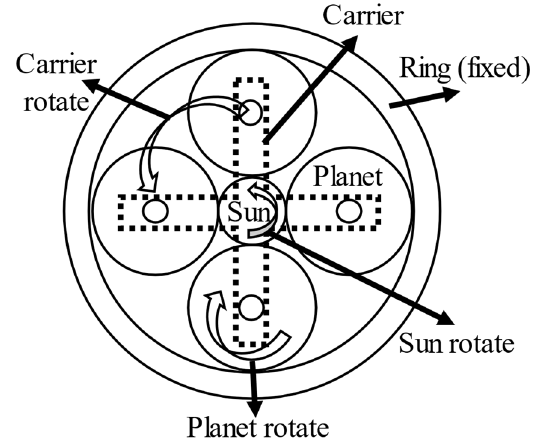
Figure 1. The structure of planetary gearbox [14].